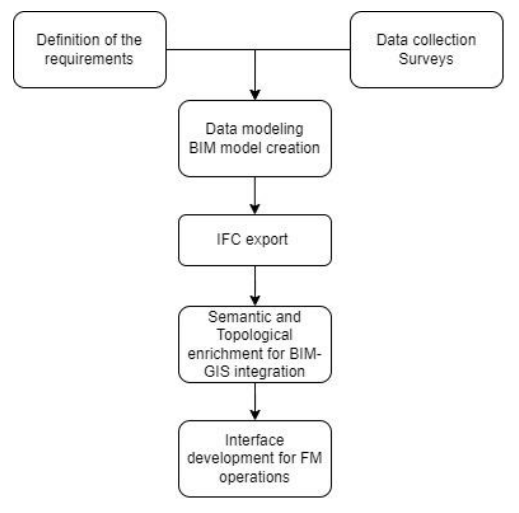
Figure 1. Framework for the GEOBIMM project.